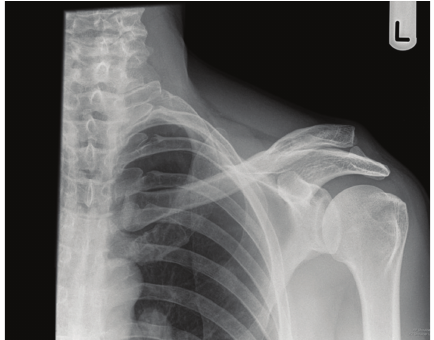
Figure 3: AP radiograph taken in emergency department at initial presentation.